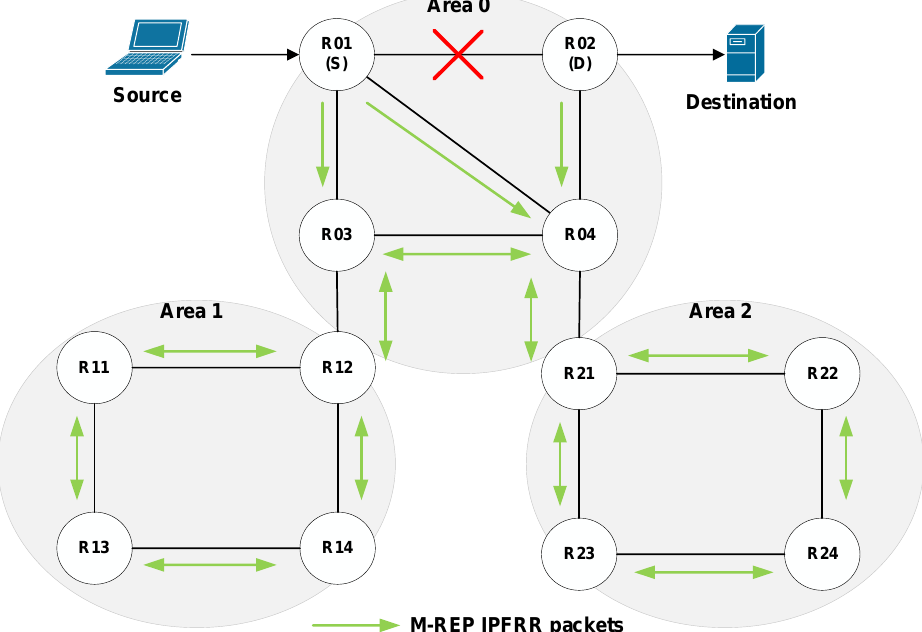
Figure 9. The process of PIM-DM flooding in multi-area Open Shortest Path First (OSPF).